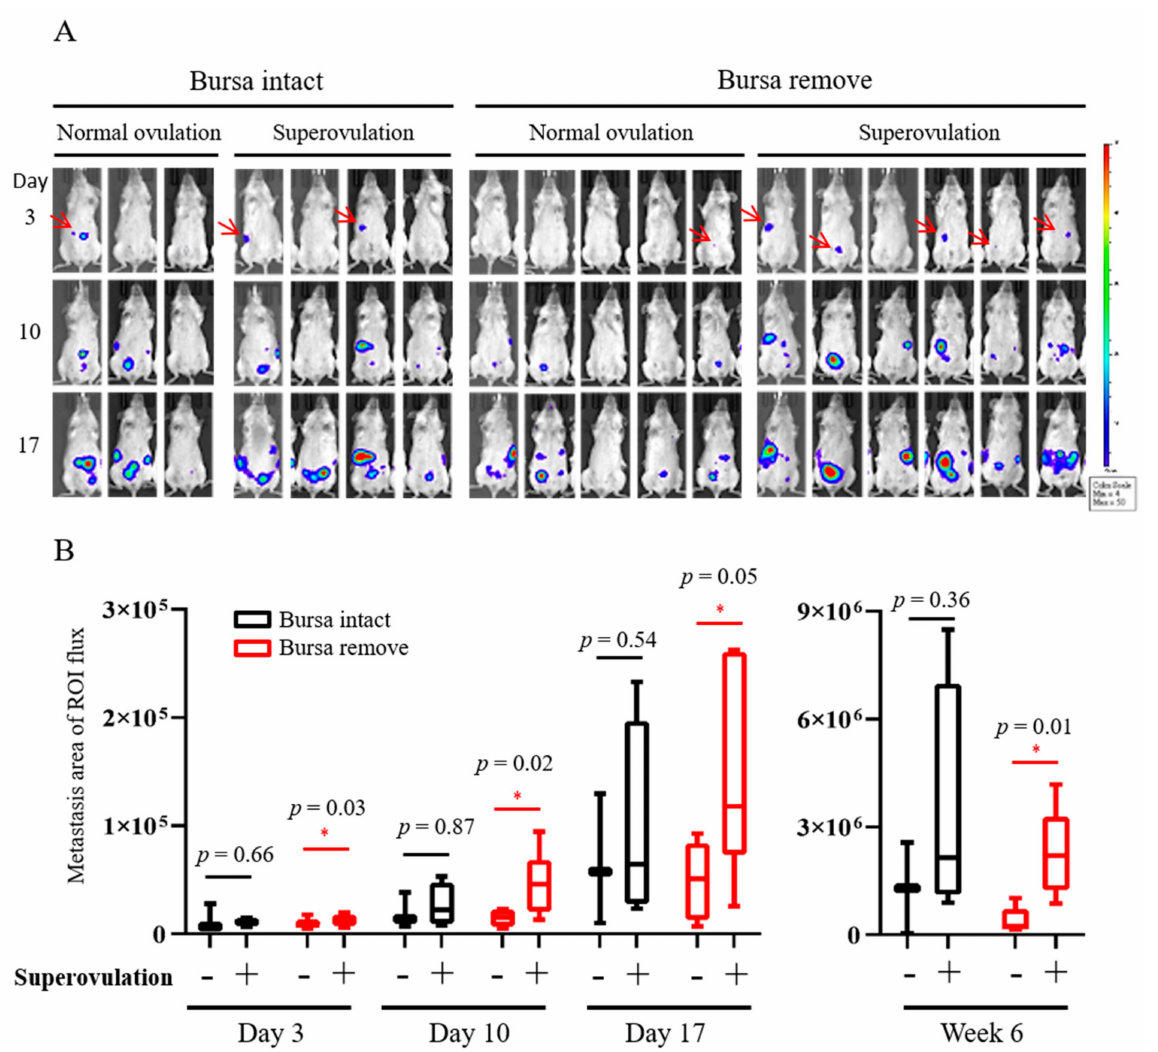
Figure 3. The bursa-free model better displays the effect of ovulation on peritoneal seedings of transformed FTE cells. ( A ) IVIS live images taken on the third, tenth, and seventeenth days after i.p. xenograft. Red arrows indicate the small lesion signal observed on the third day. ( B ) Mean IVIS signals of different mouse groups taken on days 3, 10, 17, and week 6. * p < 0.05, by two − sided, unpaired Student’s t